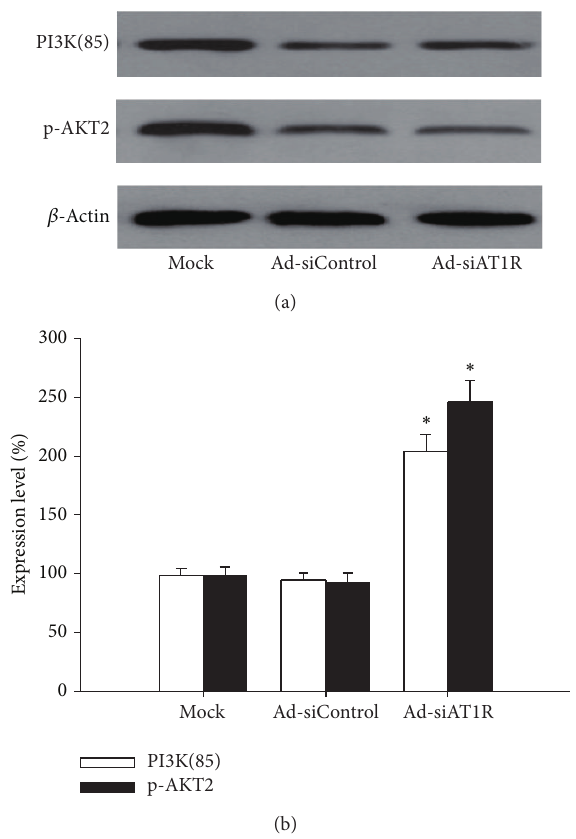
Figure 4: Effects of AT1R silencing on PI3-K(85) and p-Akt2 expression. Islets of db/db mice were transfected with Ad-si AT1R, Ad-siControl, or Mock and cells were cultured for 72 h prior to quantitative immunoblot evaluation. Results are represented as mean ± SD for six independent experiments. ∗ 𝑃 < 0.05 versus Ad- siControl.